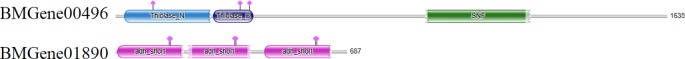
A brief gene structure map of BMGene00496and BMGene01890. Their Pfam domains were shown.